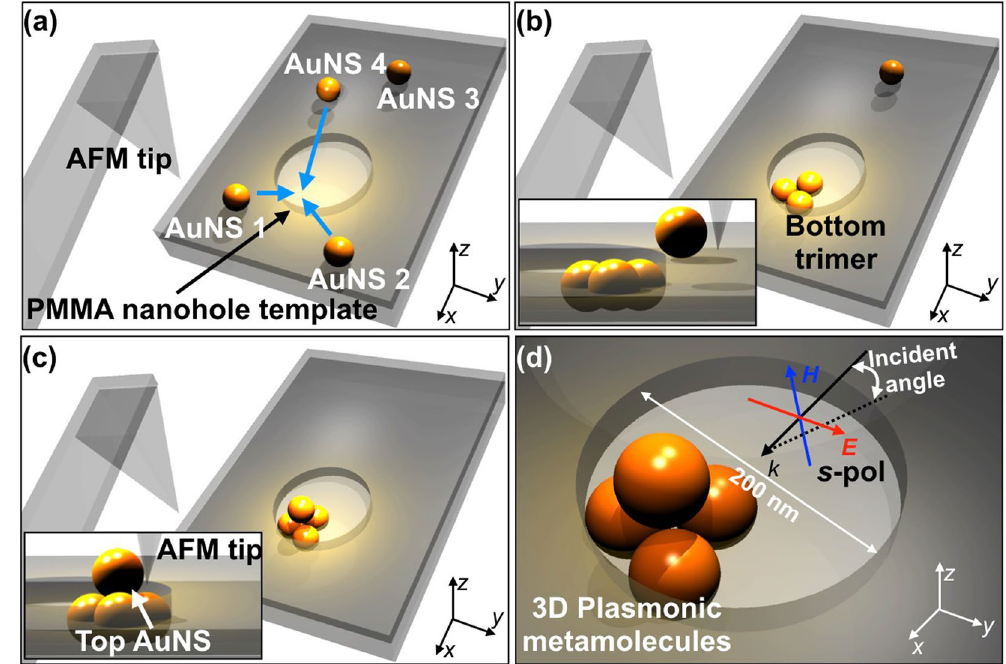
Figure 1. Schematic representation of the “3D” assembly of plasmonic metamolecules by “2D” vector nanomanipulation of an atomic force microscopy (AFM) tip. ( a ) Highly spherical and uniform gold nanospheres (AuNSs) were printed onto a poly(methylmethacrylate) (PMMA) nanohole template by dry transfer printing. ( b ) Three 77-nm-sized AuNSs were pushed and dropped onto the bottom of the